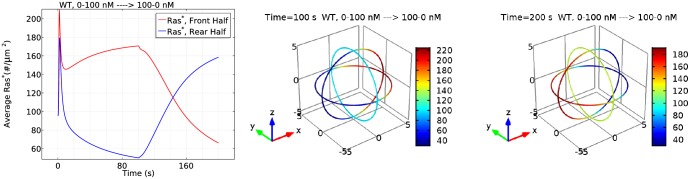
The response to gradient reversal.A linear gradient of 10nM = μm with mid point 50 nM (0–100 nM) is applied at t = 0 s and reversed at t = 100 s. The time course of average Ras* at the front and rear halves of WT cells (left) and the spatial profile of Ras* on three great circles on the sphere at t = 100 s (center) and at t = 200 s (right).